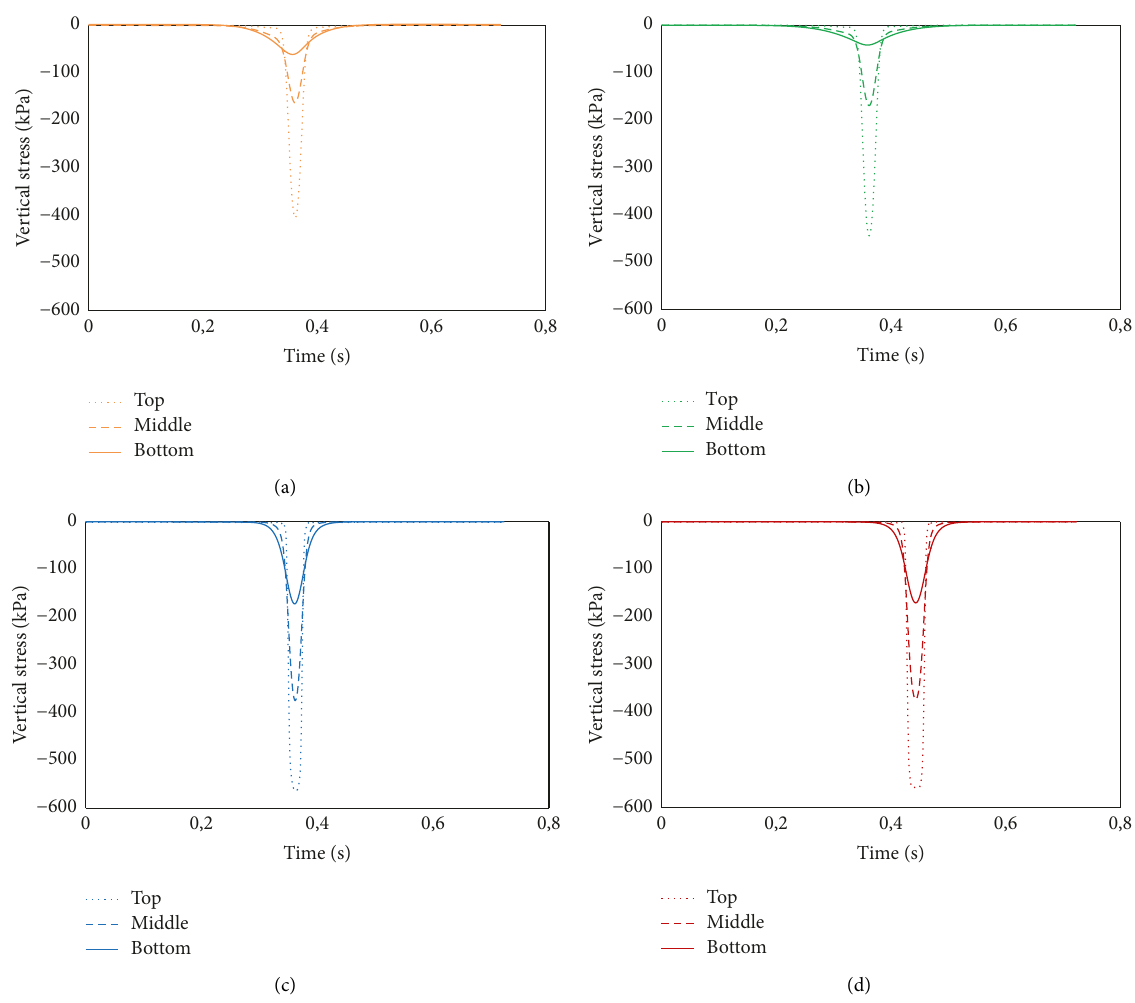
Figure 4: Vertical stress response at 40 km/h. Base layer (a) RAP_3E2C; (b) RAP_3F2C; (c) RAP_2F1H; (d)